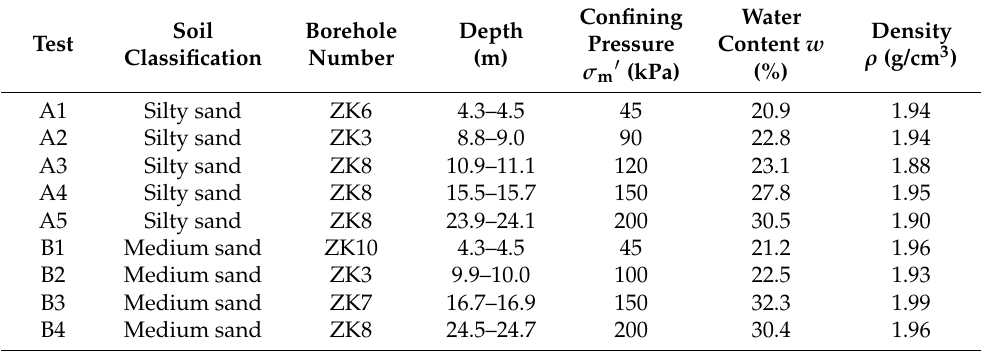
Table 1. Basic physical properties and resonant column test conditions of typical marine soil in the East Nan-ao area.